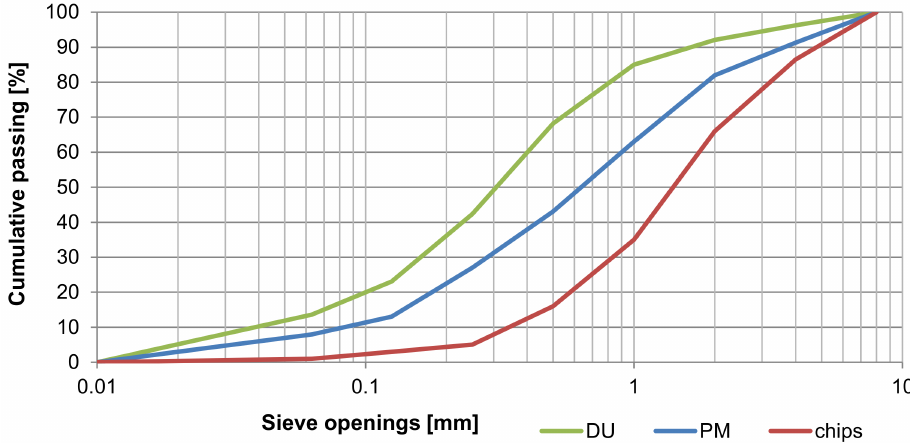
Figure 3. The results of size and particle distribution analysis of alternative raw materials DU and PM, including the comparison with the primary spruce